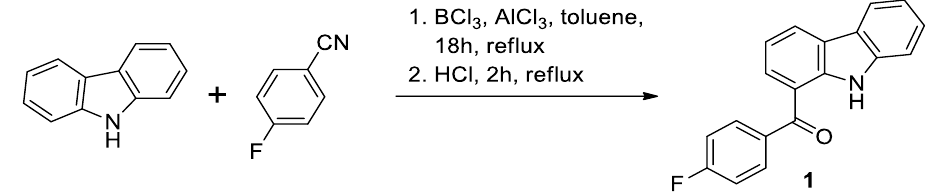
π∙∙∙π - interactions. Further weak hydrogen bonds between fluorine and the C5−H group axis. The weak interactions are shown in Figure 2 as dashed lines. axis. The weak interactions are shown in Figure 2 as dashed lines.